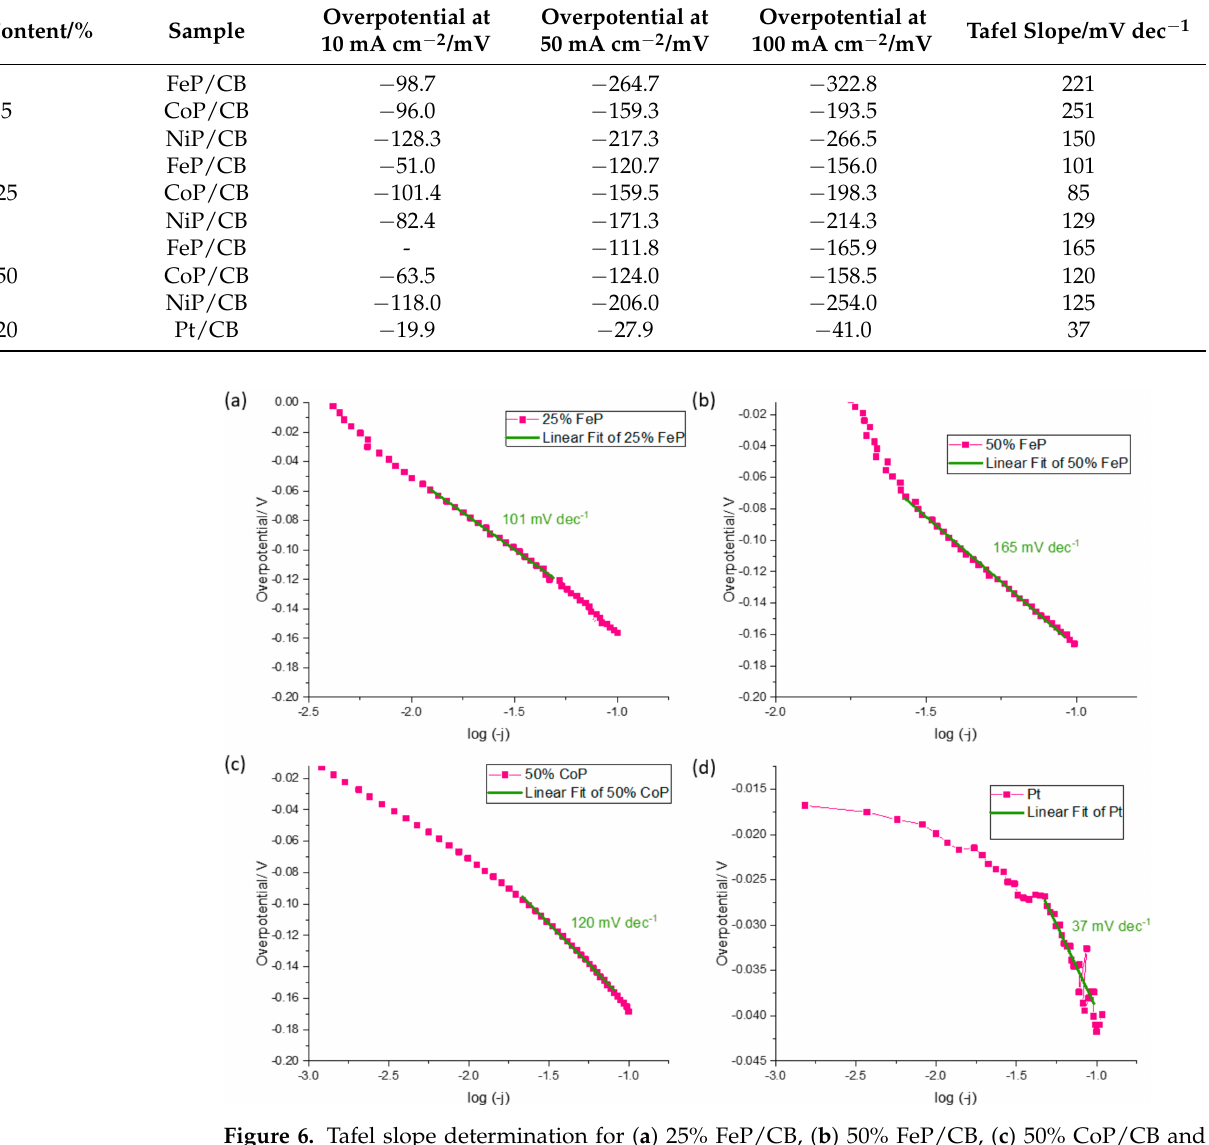
Figure 6. Tafel slope determination for ( a ) 25% FeP/CB, ( b ) 50% FeP/CB, ( c ) 50% CoP/CB and ( d )